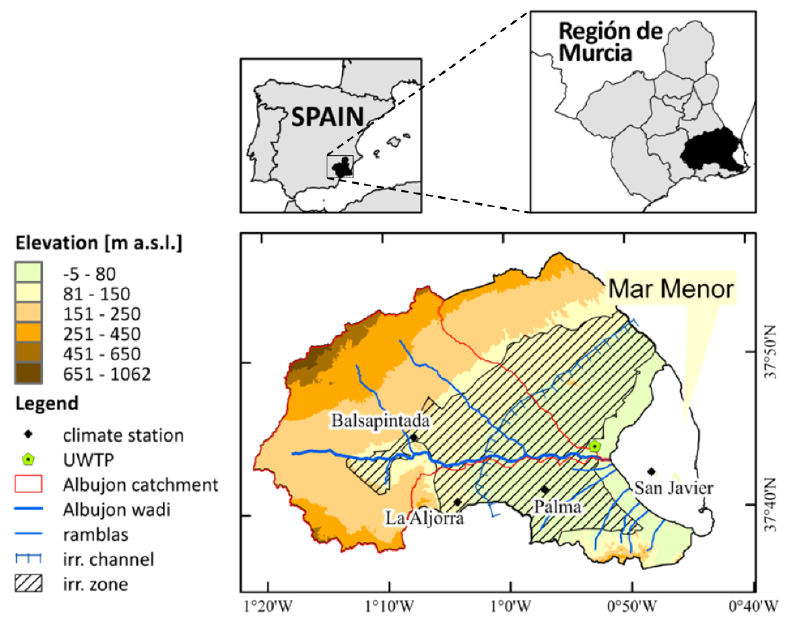
Figure 1. Geographical location of the Mar Menor catchment and major characteristics of the case study